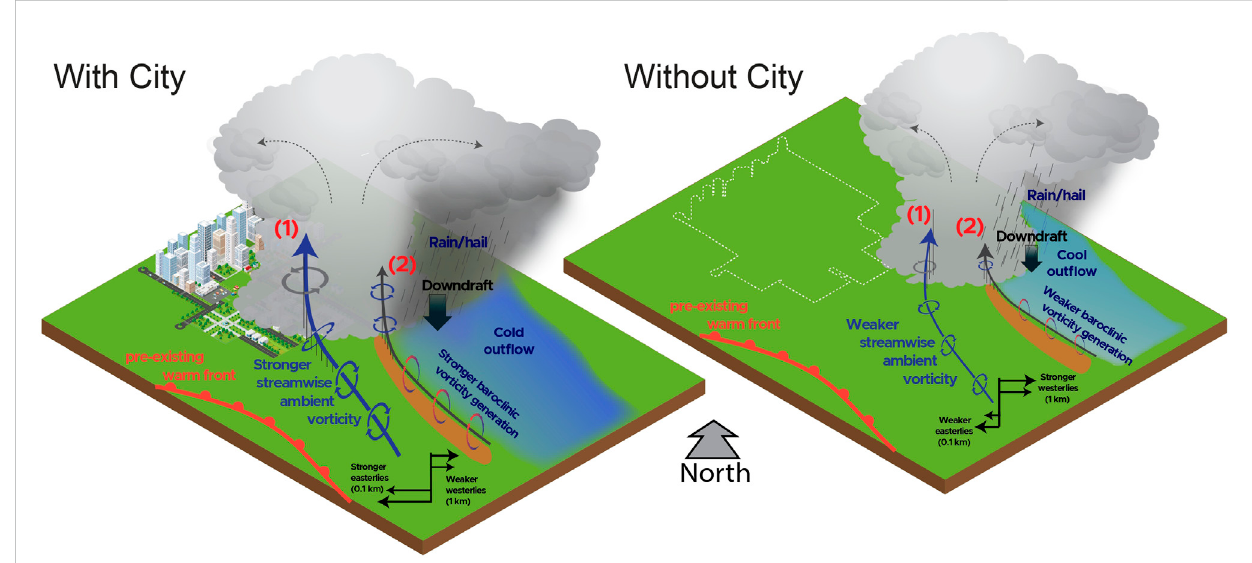
FIGURE 10 Urbanization enhances the tornado potential through two pathways: (1) enhanced low-level SRSHV feeding updrafts due to stronger east-west pressureperturbationgradientasaresultoffaster,strongerstormout fl ow,and(2)intensi fi ednear-surfaceSRSHVwhichismorealignedwiththeeasterly storm-relativein fl owbecauseofstrongercoldpoolfrontwhichincreasessoutheasterlywinds.Bothpathwaysareassociatedwithastrongerstormatthe initial and developing stages resulting from the Kansas City